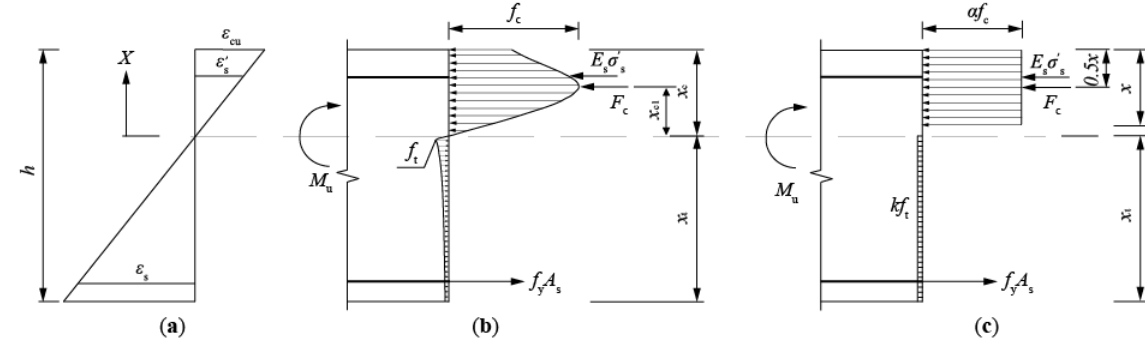
Figure 13. Ultimate limit state of T-shaped UHPC beam. ( a ) Distribution of strain; ( b ) distribution of actual stress; ( c ) equivalent stress block.